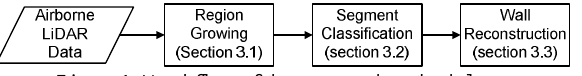
Figure 1. Workflow of the proposed methodology.